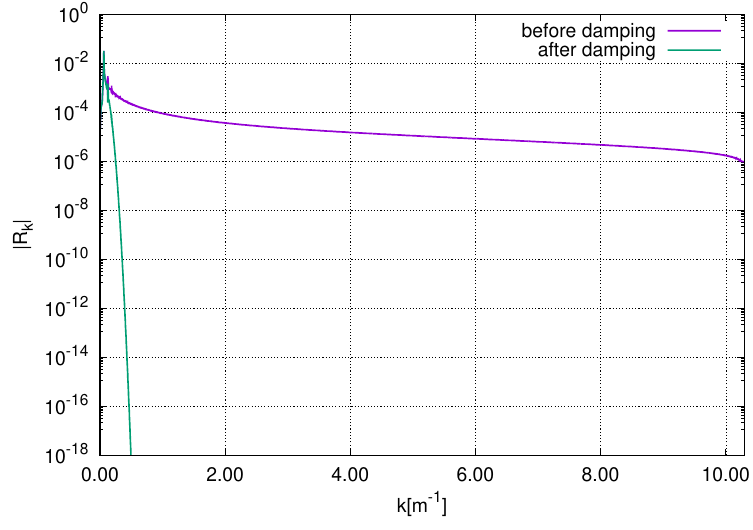
Figure 17. Fourier spectrum of R in logarithmic scale before (solid purple curve) and after (solid green curve) the